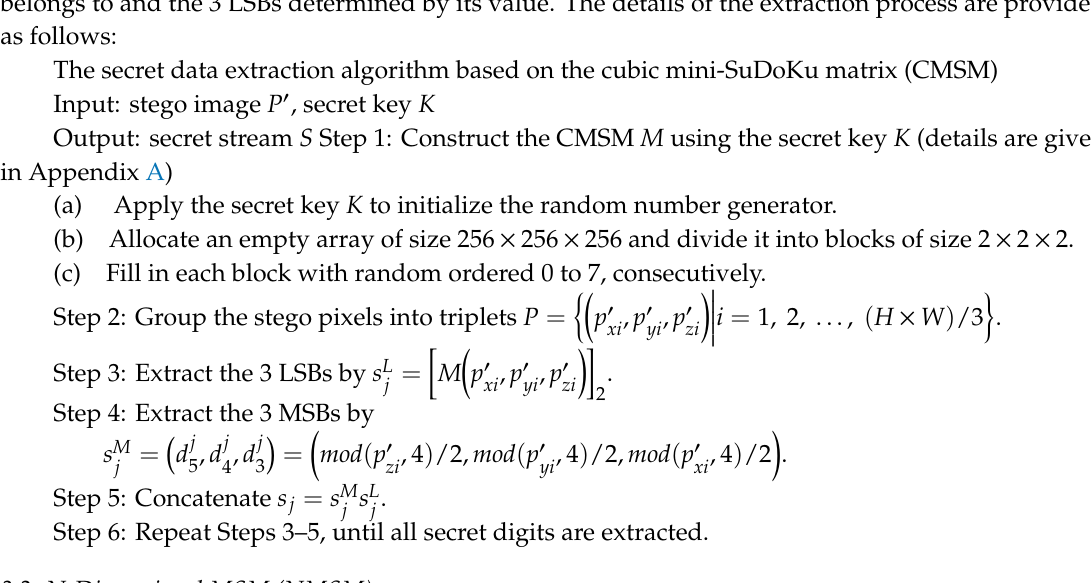
The secret data extraction algorithm based on the cubic mini-SuDoKu matrix